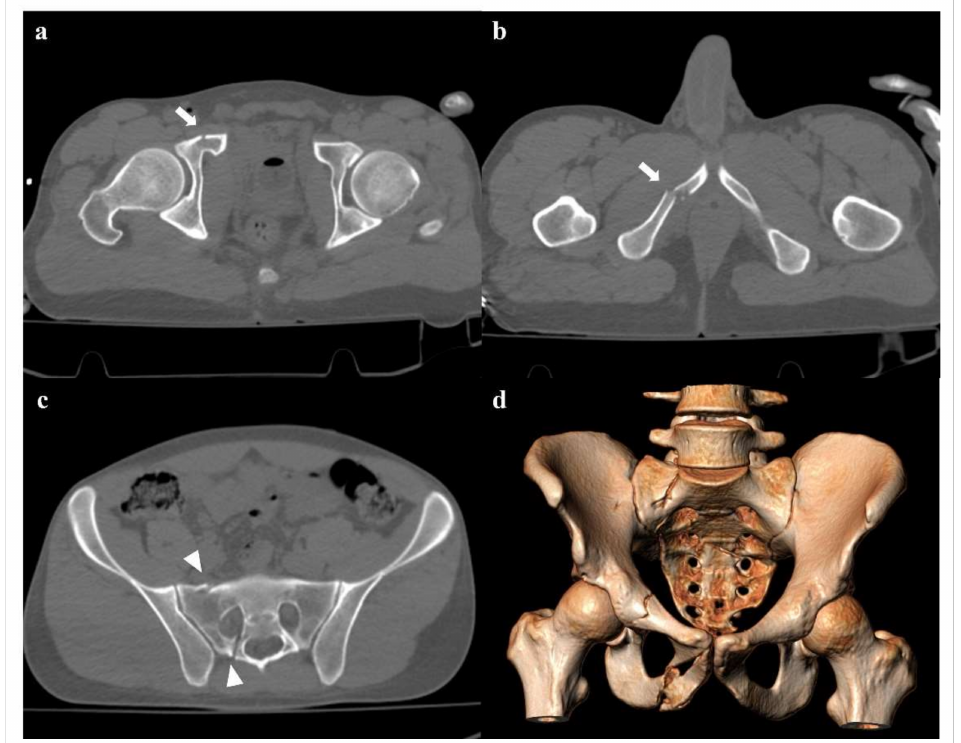
Figure 1. Lateral compression fracture, type 1. Axial computed tomography (CT) images show a fracture of the right-side superior and inferior pubic rami (arrows in ( a , b )), and ipsilateral fracture of the sacrum (arrowheads in ( c )); the sacral fracture involves the neuroforamina (zone II). Three- dimensional volume-rendering CT reconstruction in anteroposterior (AP) view confirms the type of fracture ( d